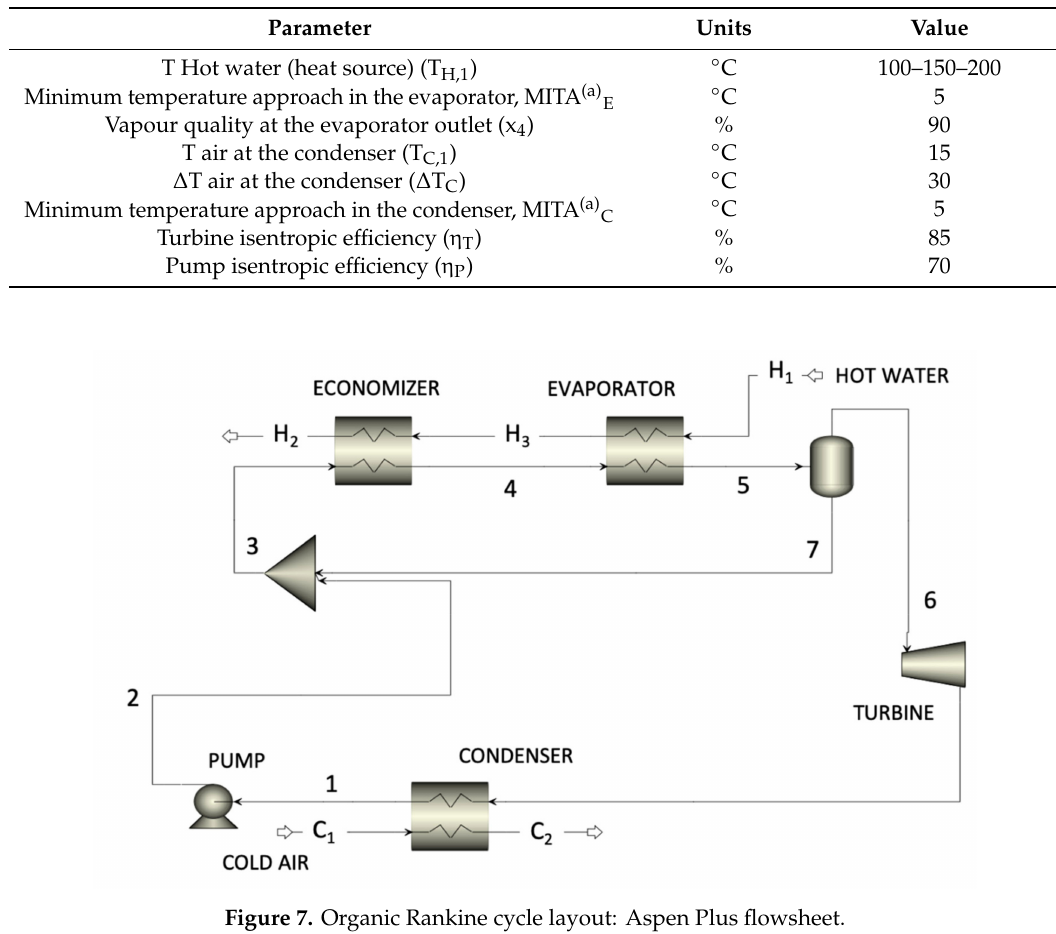
Table 3. Organic Rankine cycle (ORC) system: main assumptions and parameters. (a) The “minimum temperature approach” is the minimum temperature di ff erence between the two streams in the